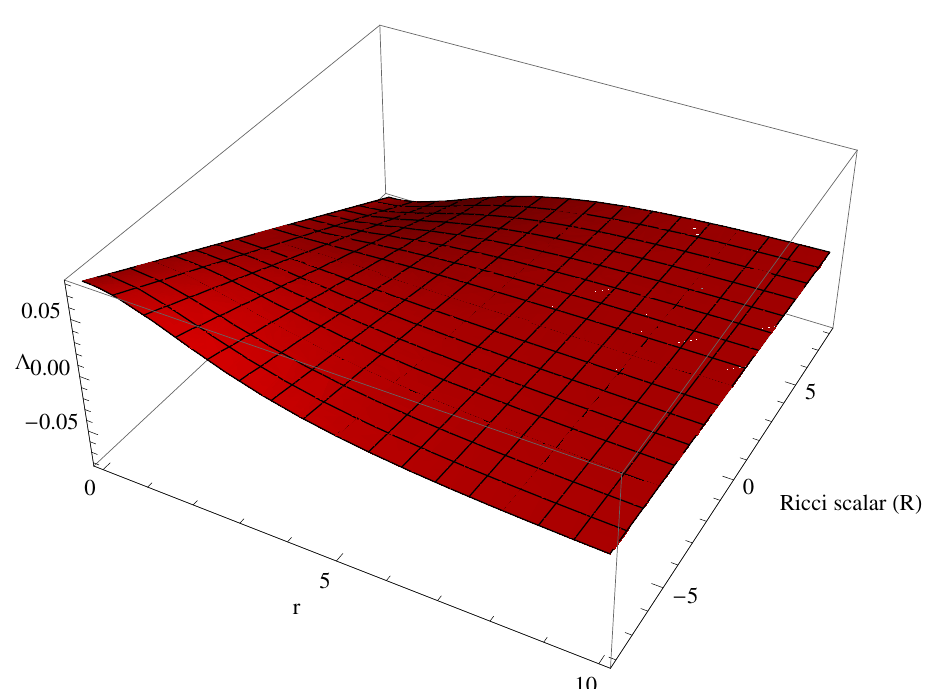
Figure 25. The behaviour of the cosmological constant in presence of perfect fluid matter source is plotted against the Ricci scalar R with the values of the arbitrary constants λ = − 0.1, C 3 = 2, C 4 = 0.001, C 5 = 10.